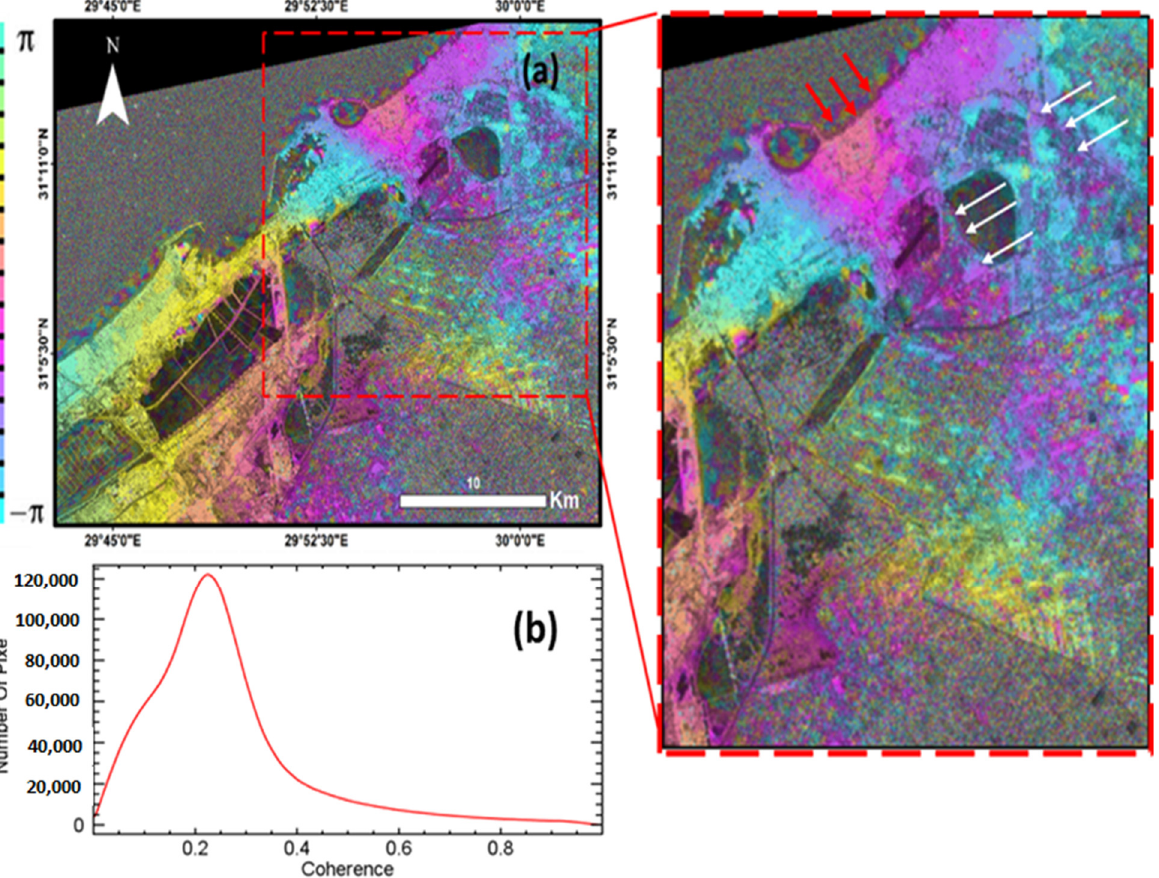
Figure 6. ( a ) Wrapped ALOS-2 low coherent interferogram showing errors during the flattening sub-step; white arrow indicates systematic residual fringes that could have been caused by strong orbital inaccuracy or issues with some parameter settings, while red arrows indicate strong atmospheric artifacts and phase jumps. ( b ) Histogram representing the coherence value of interferogram with a mean coherent value of 0.15.